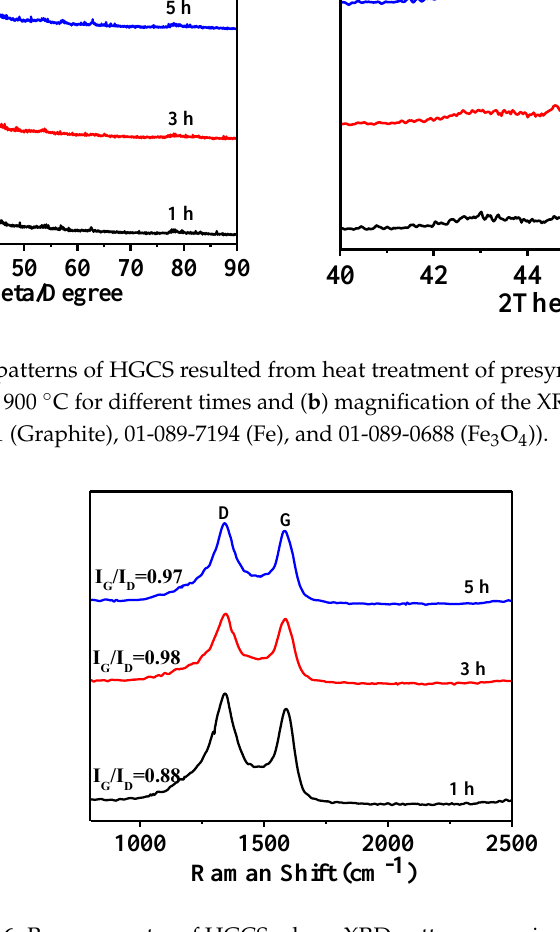
Figure 6. Raman spectra of HGCS whose XRD patterns are given in Figure 5.